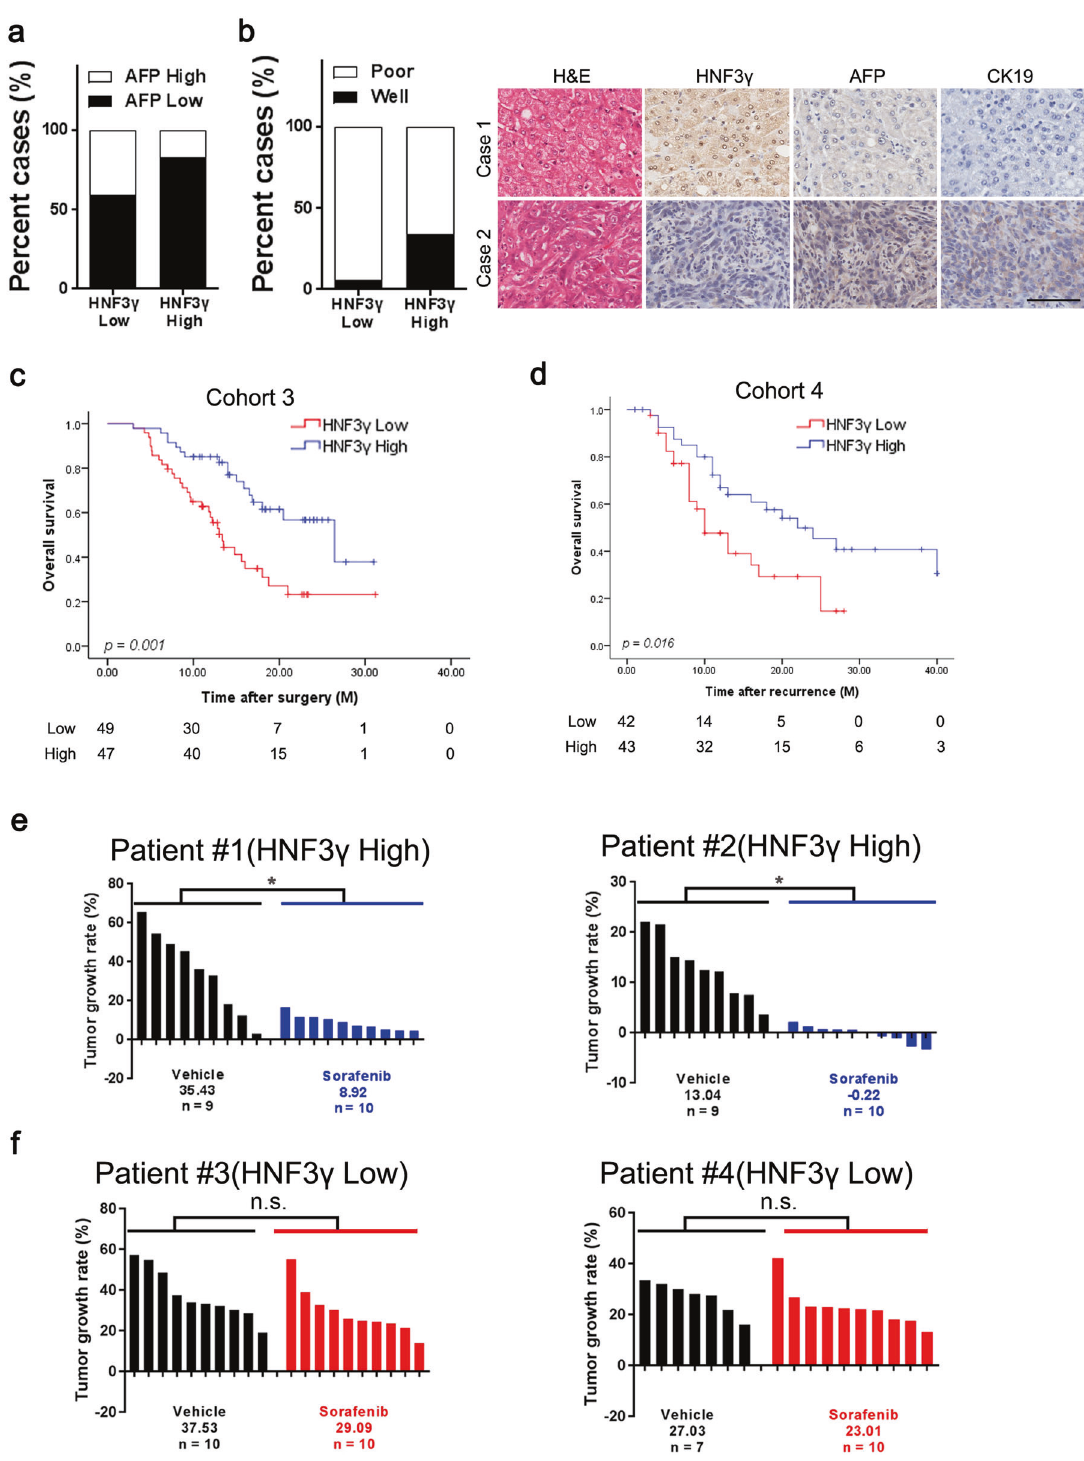
Fig. 8 HNF3 γ levels in patient HCCs correlate with sorafenib bene fi t. a The correlation between HNF3 γ expression and AFP levels was evaluated in 67 HCC patients using a chi-square test. b The correlation between HNF3 γ expression and HCC differentiation was evaluated in patient HCC tissues using a chi-square test (left). H&E and IHC staining for the dedifferentiation markers AFP and CK19 were conducted, and the representative images are shown (right). Scale bar, 100 μ m. c HNF3 γ expression was examined by IHC staining in HCC samples from 96 patients who had received adjuvant sorafenib therapy after surgery. Overall survival of patients between the HNF3 γ -high and HNF3 γ -low groups was compared with Kaplan – Meier analysis. d HNF3 γ expression was examined by IHC staining in primary HCC samples from 85 patients who had received sorafenib treatment for recurrent tumors. The overall survival of patients between the HNF3 γ -high and HNF3 γ -low groups was analyzed with Kaplan – Meier analysis. e , f PDXs with high or low HNF3 γ expression in their primary HCC tumors indicated by IHC staining scores (details can be found in “ Materials and methods ” ) were treated with sorafenib (30 mg/kg body weight) or vehicle for 28 days. Xenografted tumor growth was monitored, and the tumor growth rates were